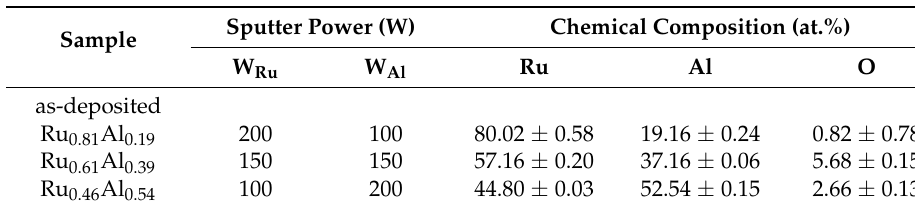
Table 2. Chemical compositions of Ru–Al thin films deposited on Inconel 617 with a Ru interlayer.